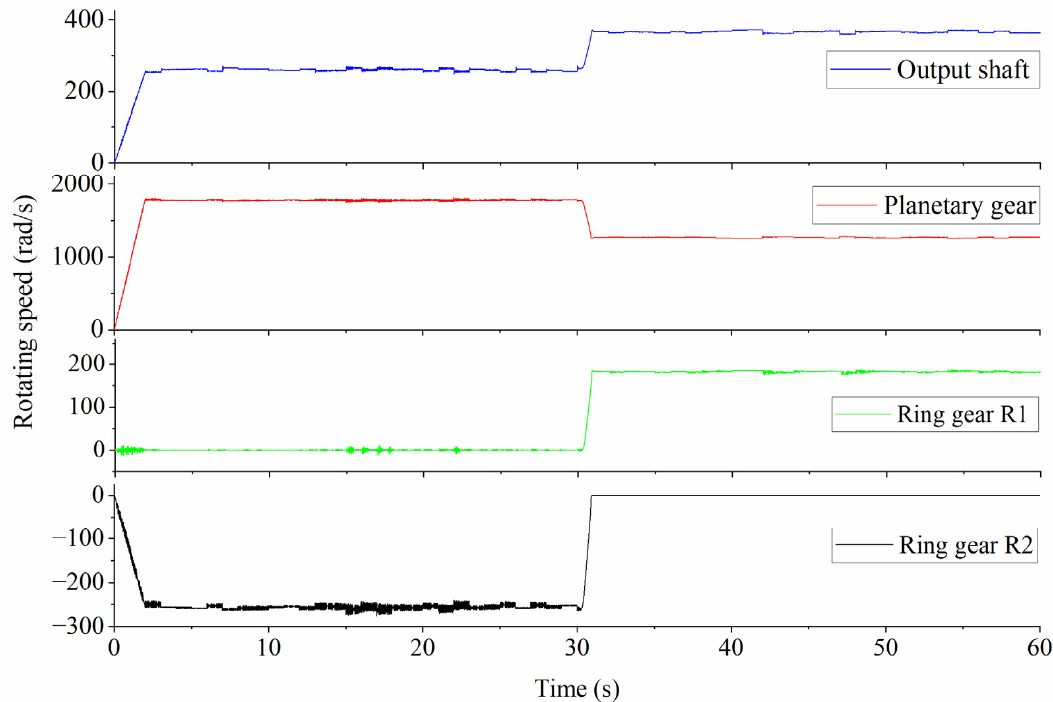
Figure 16. Waveforms of the output shaft, planetary gear, ring gear R1, and ring gear R2 rotating speeds.